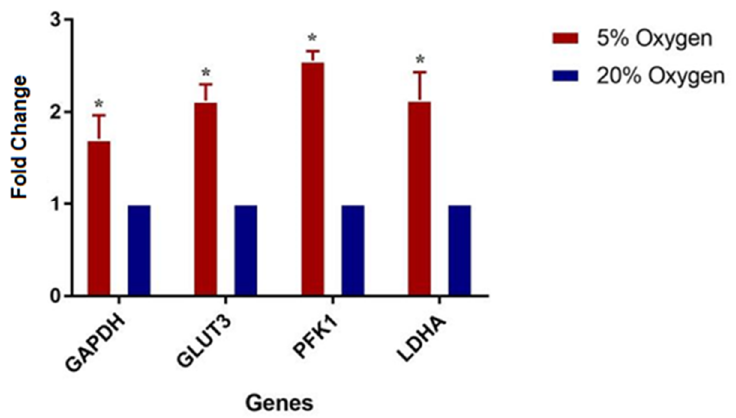
Figure 9. The real time qPCR analysis showing the elevated expression of GAPDH, GLUT3, PFK1 and LDHA in embryos cultured under low oxygen as compared to atmospheric oxygen. Asterisk (*) indicates the significant difference ( p < 0.05) between the groups.